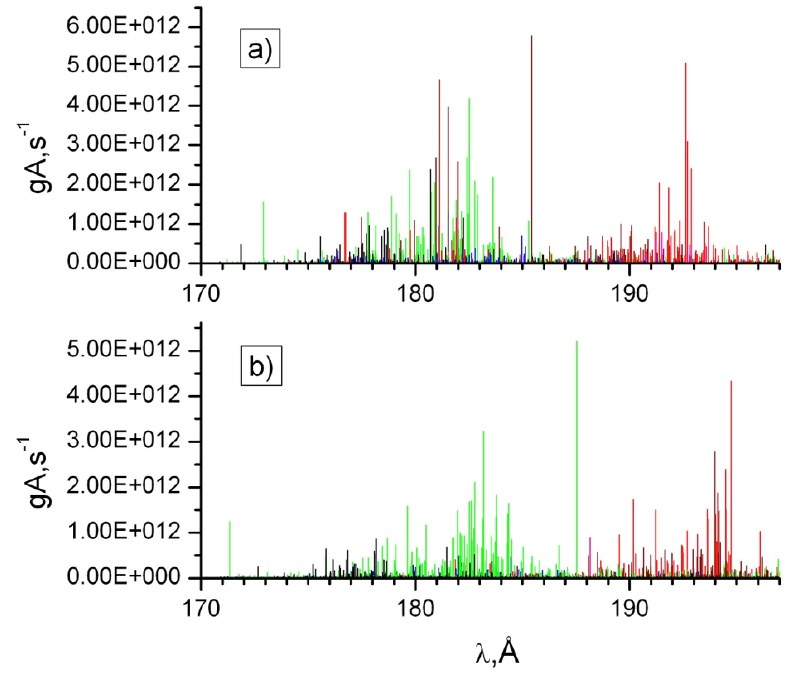
Figure 10. Calculated W IX spectrum: ( a ) “standard” scaling of Hartree-Fock parameters; ( b ) the Hartree-Fock parameters are scaled by the scaling factors taken from the W VIII spectrum. The colours of calculated lines correspond to the colours of transitions in Figure